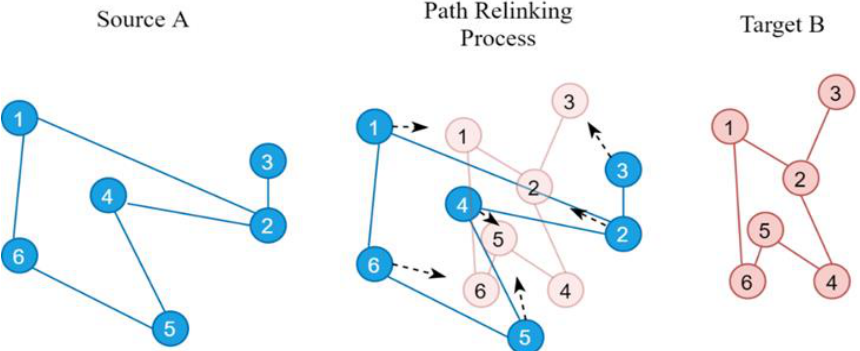
Figure 7. Path relinking